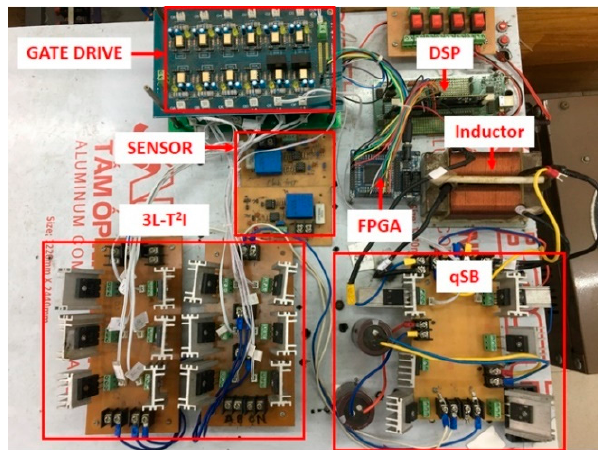
Figure 11. Experimental prototype.